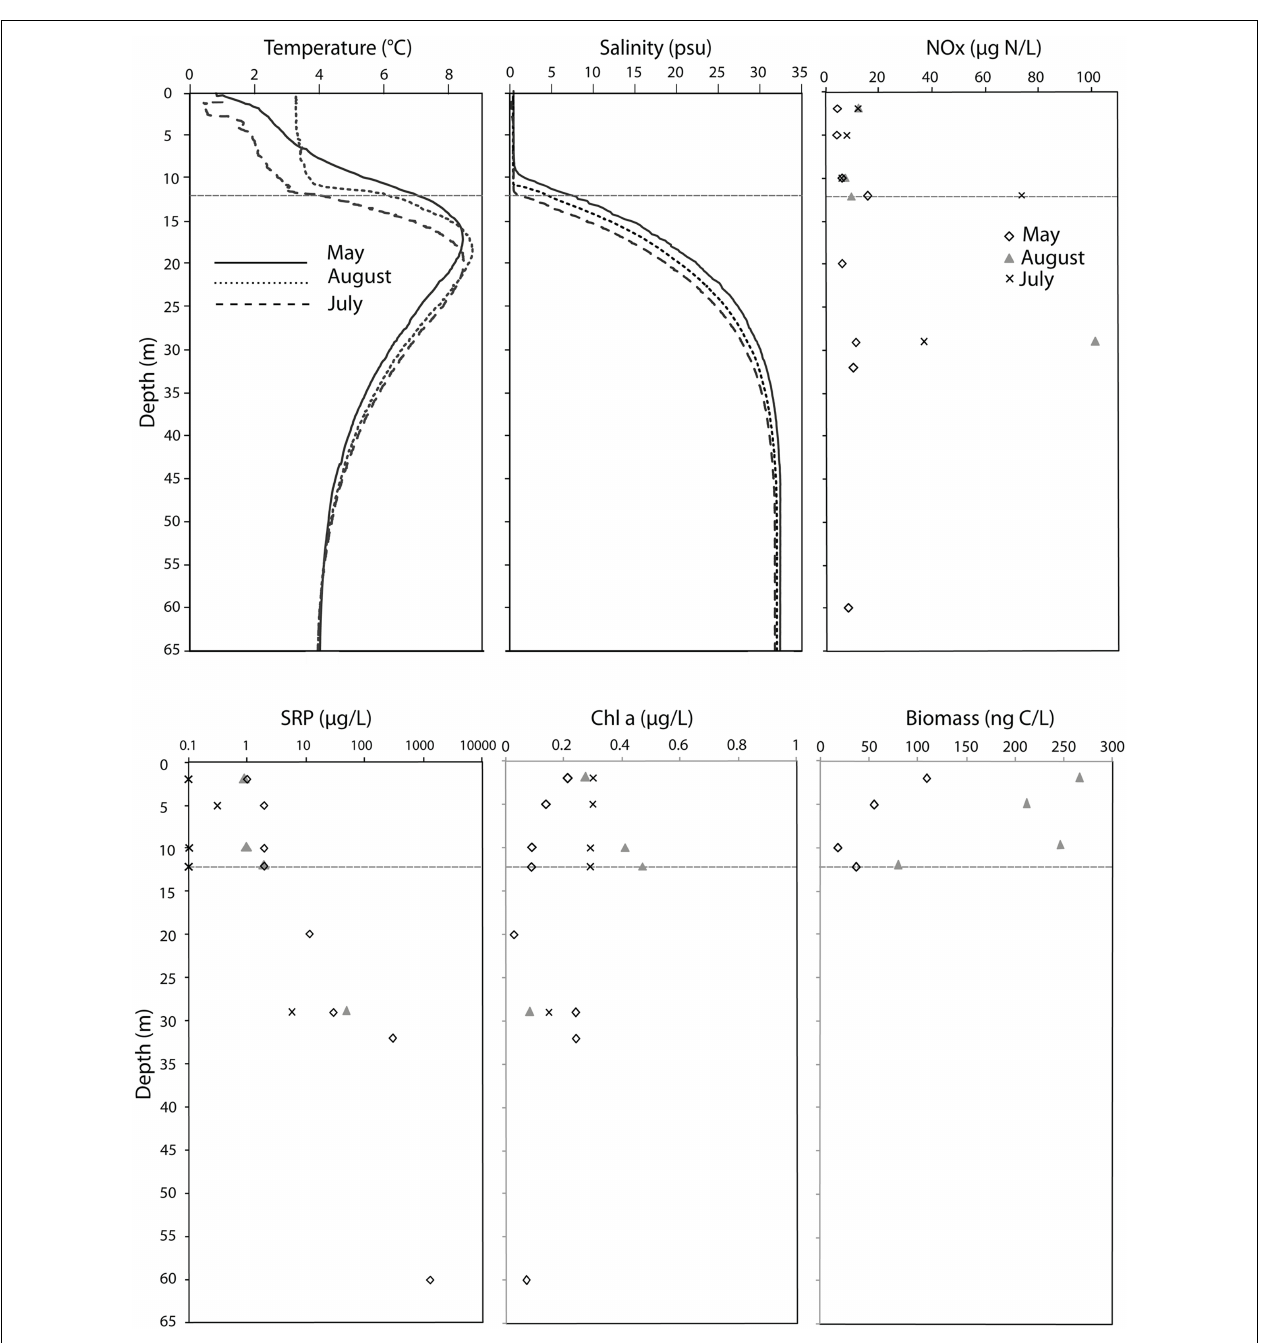
FIGURE 1 | Environmental variables of the LakeA water column in May 2008,August 2008 and July 2009. NOx, nitrate and nitrite concentrations; SRP, soluble reactive phosphorus (note the logarithmic scale); Chl a , chlorophyll a .The depth axis is in